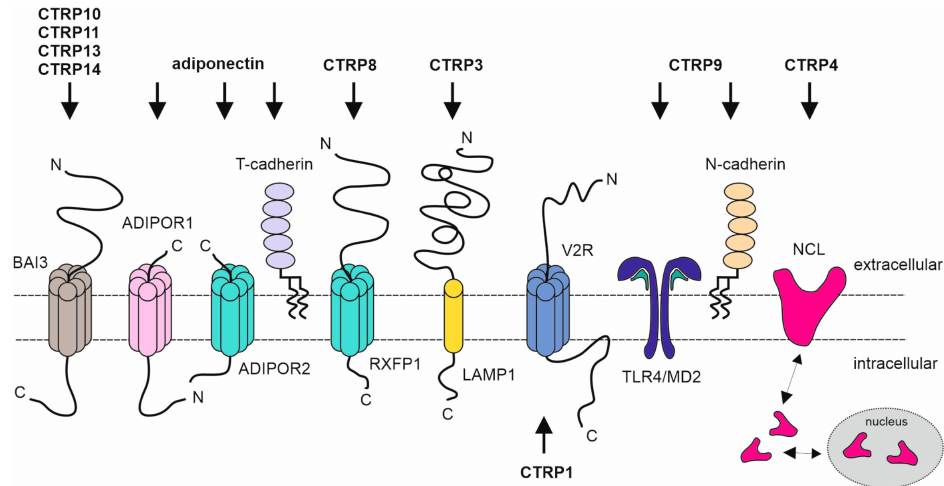
Figure 2. Schematic overview of known CTRP receptors. CTRP10, − 11, − 13 and − 14 bind to and interact with the brain-specific angiogenesis inhibitor 3 (BAI3), a member of the cell-adhesion class of G protein-coupled receptors (GPCR). Adiponectin is a ligand for adiponectin receptors 1 and 2 (AdipoR1 and AdipoR2) and can also interact with T-cadherin. CTRP8 is described to interact with